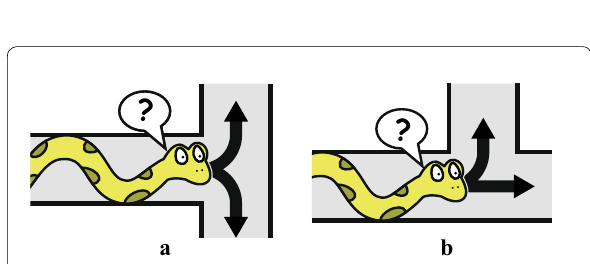
Fig. 5 Two branching system types. Type A ( a ) and Type B ( b ). Type A includes a 180° fork, and Type B includes a straight path and a